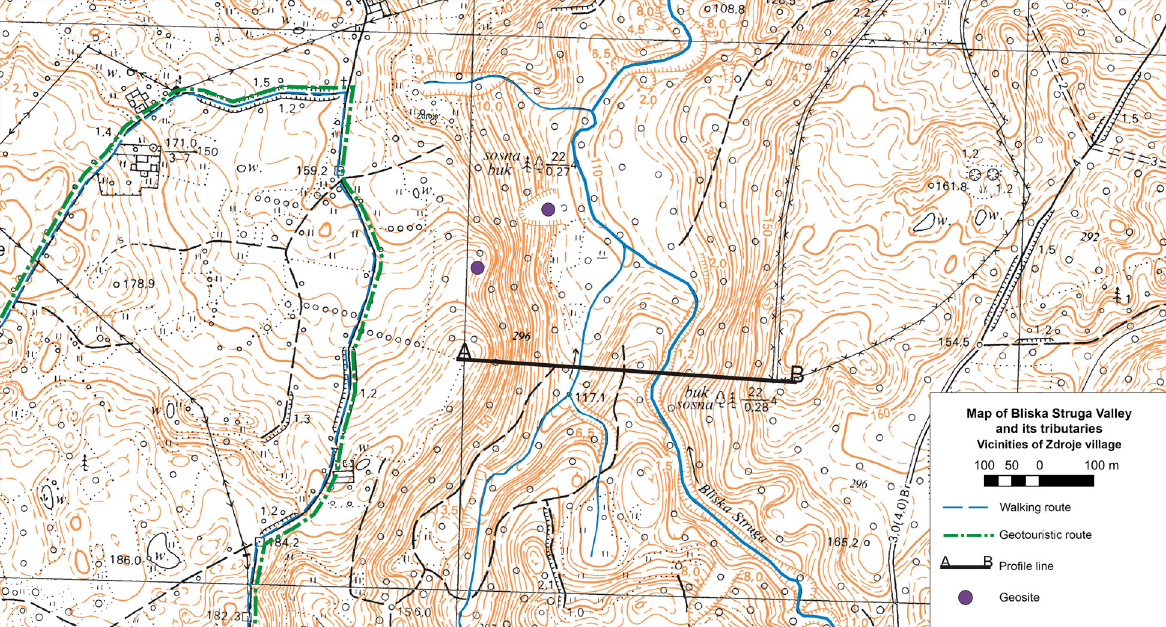
Fig. 3. Topographic map with the line of geological cross-section through the Ravine of the Bliska Stream and its tributaries acc. to kamieńska, Giemza